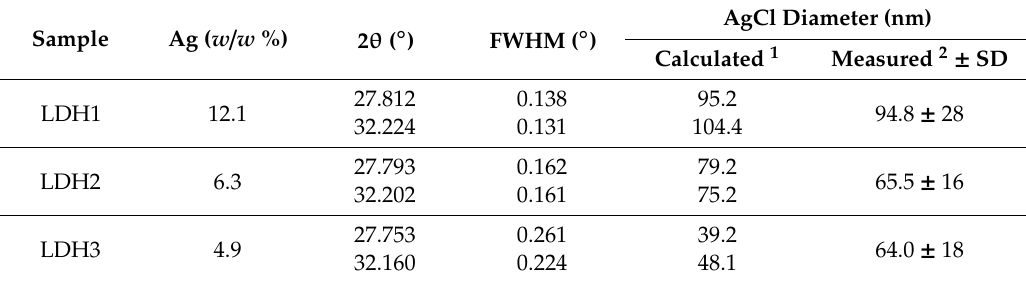
Figure 2. XRD of LDH1 ( a ), LDH2 ( b ) and LDH3 ( c ). The spectral regions, from 25 to 70 2 θ ◦ , have been magnified ten times to highlight the AgCl reflections labeled with dashed lines (PDF number: 85-1355). * reflections ( 111 ) e ( 200 ) of the cubic phase of metallic silver. Table 1. Weight percentage of silver and diameter of AgCl of the indicated samples. FWHM: Full width at half